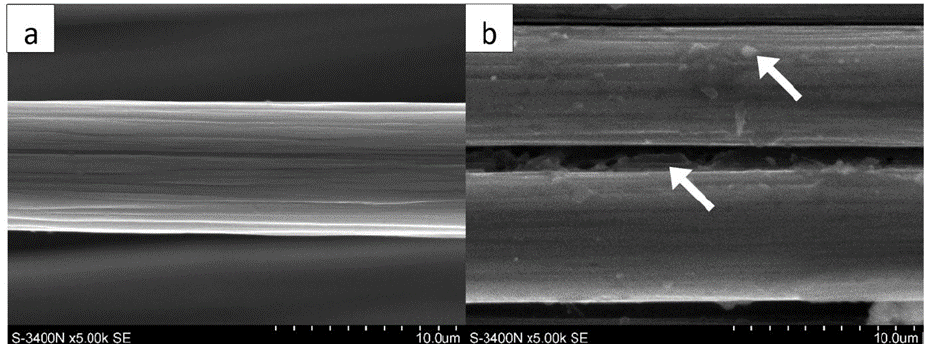
Figure 2. SEM images of studied carbon fibers: ( a ) the original carbon fiber, ( b ) the pyrolytic carbon fibers (Hitachi S− 4200, SE technique, magnification 5000× ) . fibers (Hitachi S-4200, SE technique, magnification 5000 × ).